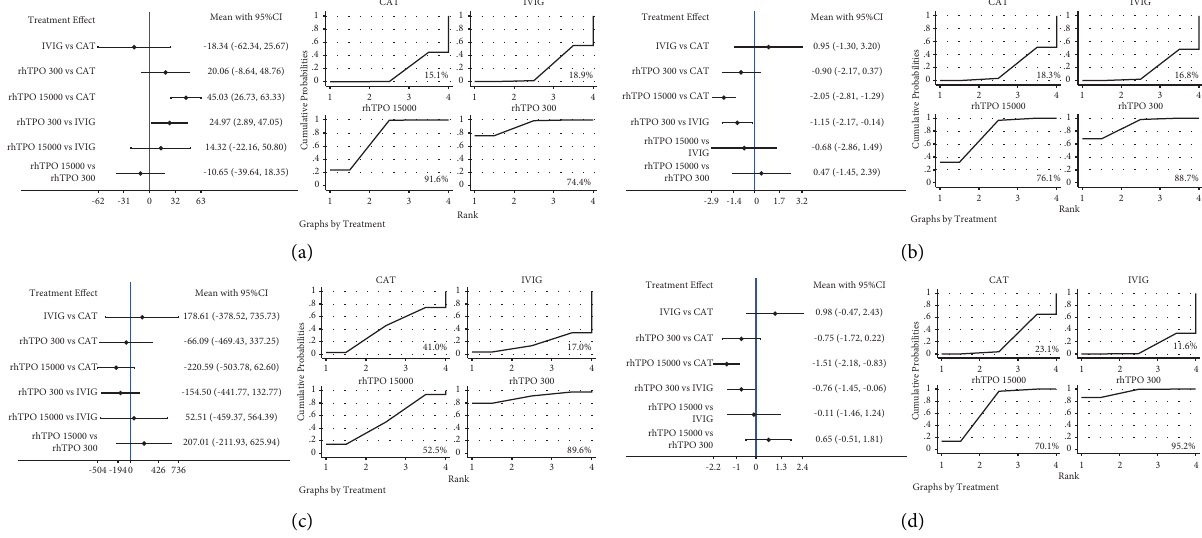
Figure 6: Network meta-analysis of the relative efcacy and the rank probabilities among diferent treatment strategies in terms of the level of platelet on the 7 th day (a), transfusion of RBC (b), transfusion of plasma (c), and transfusion of platelets (d). NAT, no additional treatment; IVIG, intravenous immunoglobulin; rhTPO 300, 300U/kg/d recombinant human thrombopoietin; rhTPO 15000, 15000U/ d recombinant human